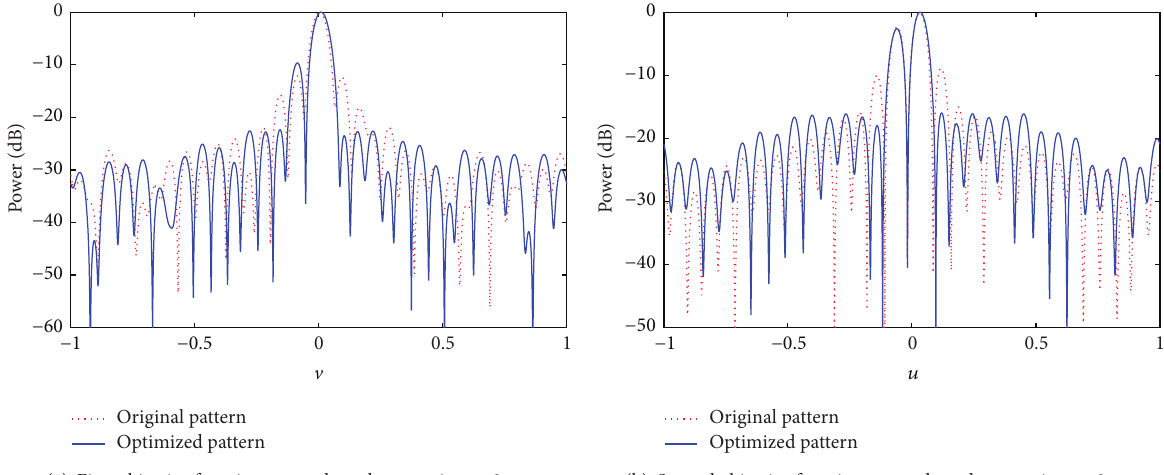
Figure 19: Optimized results based on MOEA.